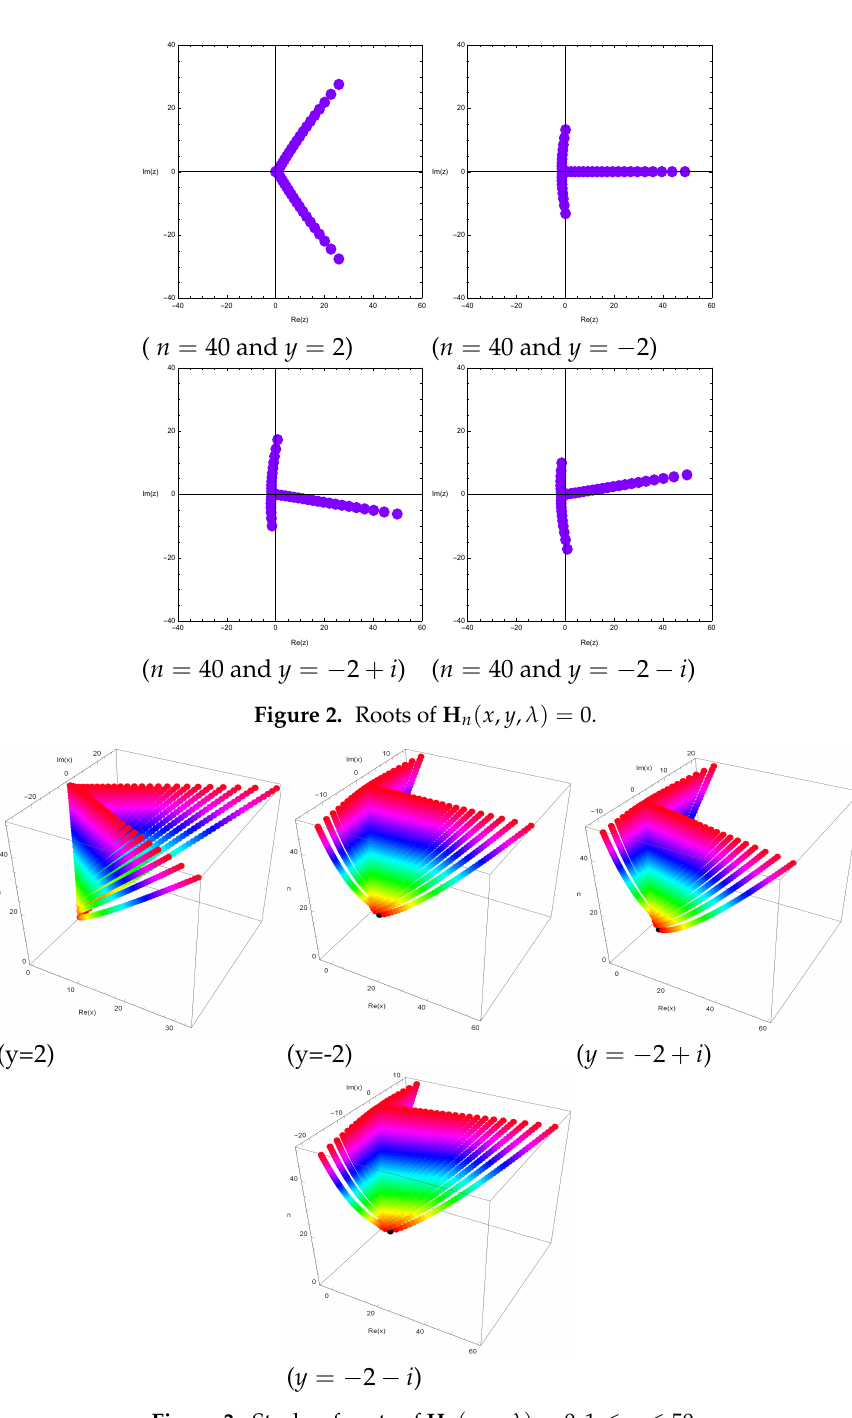
Figure 3. Stacks of roots of H n ( x , y , λ ) = 0,1 ≤ n ≤